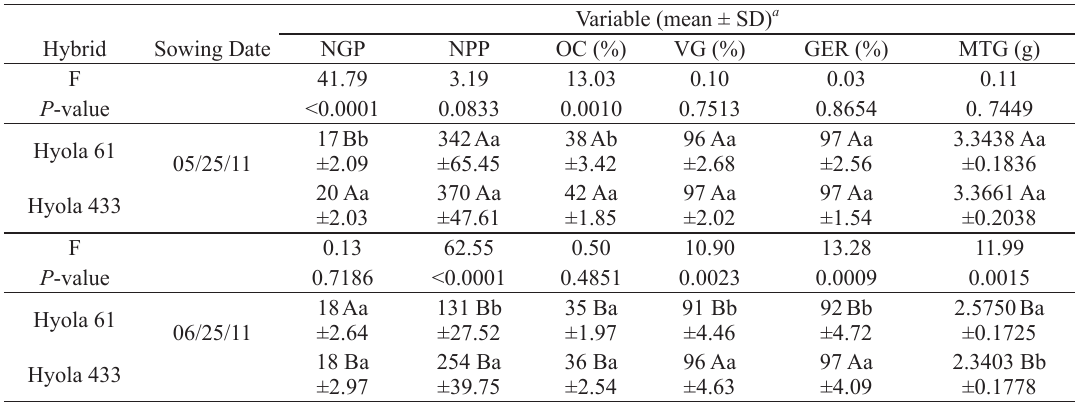
F probability values and means ± standard deviation values for number of grains per pod (NGP), number of pods per plant (NPP), oil content (OC), vigor (VG), germination (GER) and mass of 1,000 grains (MTG) per rapeseed hybrid and sowing date combination in Marechal Cândido Rondon (state of Paraná,